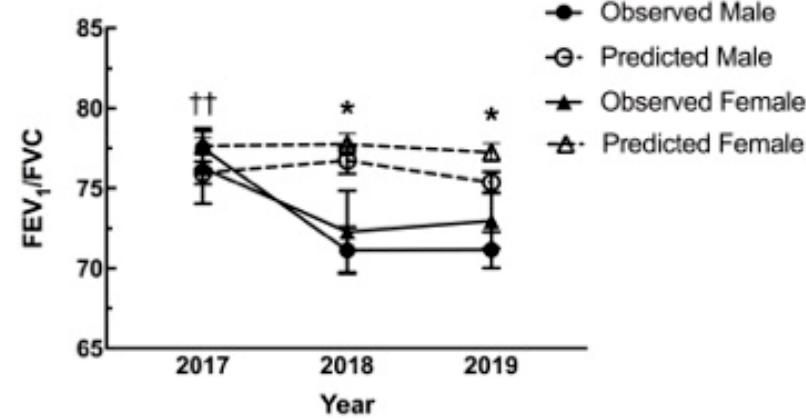
Figure 2. Pulmonary function changes from predicted values. The graph depicts the changes to lung function (FEV 1 / FVC) in 2018 and 2019 following the Rice Ridge fire in Seeley Lake, MT. In both years following the 2017 exposure the observed (solid lines) was significantly lower than predicted (dashed) for males (* M, circles), while significantly lower in 2019 for the females (* F, triangles). In addition, the male values were significantly lower as compared to the observed values in 2017. (* p < 0.05 Observed vs. Predicted within Sex; †† p < 0.01 Significant compared to 2017 for corresponding group).